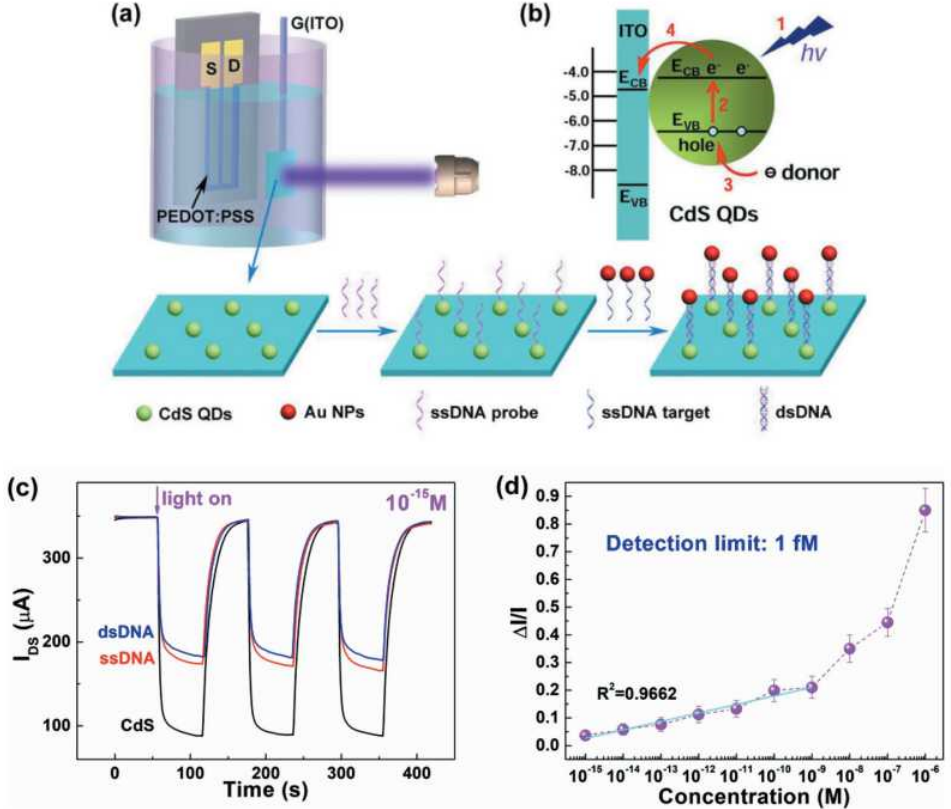
Figure 7. ( a ) Schematic diagram of an organic photoelectrochemical transistor (OPECT)-based biosensor for the DNA detection, and ( b ) the charge transfer between CdS quantum dots (QDs) and indium tin oxide (ITO) gate electrode under light illumination. ( c ) Channel current ( I ds ) versus time at several repeated light on/off cycles with the immobilization of DNA. The concentration of the ssDNA probes is 1 × 10 − 15 M. ( d ) Dependence of ∆ I / I on the concentration of ssDNA targets. Figure reproduced with permission from reference